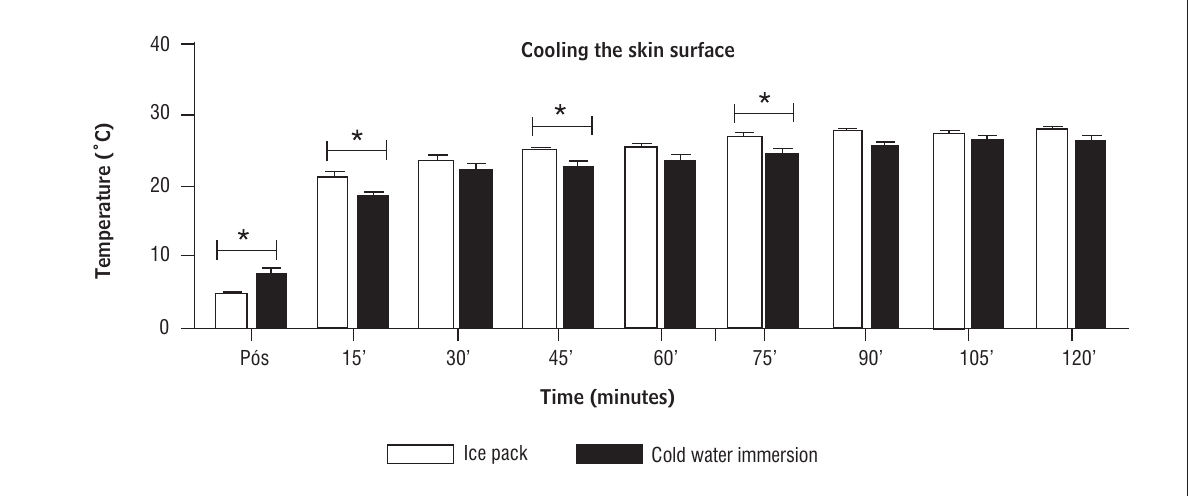
Figure 2 - Mean and standard deviation of the skin temperature over the anterior talofibular ligament of the ankle measured after the application of cryotherapy Note: *P ≤ 0.05